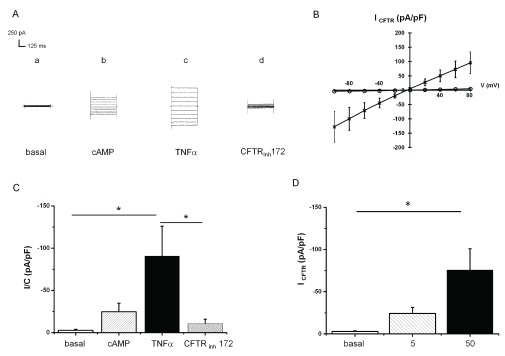
Effect of TNFα on whole-cell Cl
- currents recorded in HeLa cells expressing F508del-CFTR by patch-clamp experiments.* indicates significant results.
A. Representative current traces recorded by holding the membrane potential at 0 mV and by pulsing the voltages in the range -100 mV to +80 mV at 20 mV steps. Current traces recorded: at the basal level (
a); in the presence of CPT-cAMP/IBMX (
b); in the presence of 50 TNFα+CPT-cAMP/IBMX (
c); in the presence of 5 µM CFTR
Inh172, 50ng/ml TNFα and 400 µM CPT-cAMP/IBMX (
d).
B. Mean CFTR-related current amplitudes recorded at -60 mV and normalized to cell capacitance in the presence of CPT-cAMP/IBMX (
O); in the presence of 50 TNFα+CPT-cAMP/IBMX (
X).
C. Mean current amplitudes recorded at -60 mV and normalized to cell capacitance (means + SEM, N=8): at the basal level; in the presence of CPT-cAMP/IBMX; in the presence of 50 TNFα+CPT-cAMP/IBMX; in the presence of 5 µM CFTR
Inh172, 50ng/ml TNFα and 400 µM CPT-cAMP/IBMX. Wilcoxon signed rank test (paired samples): basal vs TNFα p=0.014, TNFα vs CFTR
inh 172 p=0.014.
D. Dose-response of 0 to 50ng/ml TNFα after 10min: mean CFTR current amplitudes recorded at -60 mV and normalized to cell capacitance (means + SEM; ns for 5ng/ml N=4; p<0.05 for 50ng/ml n=8).